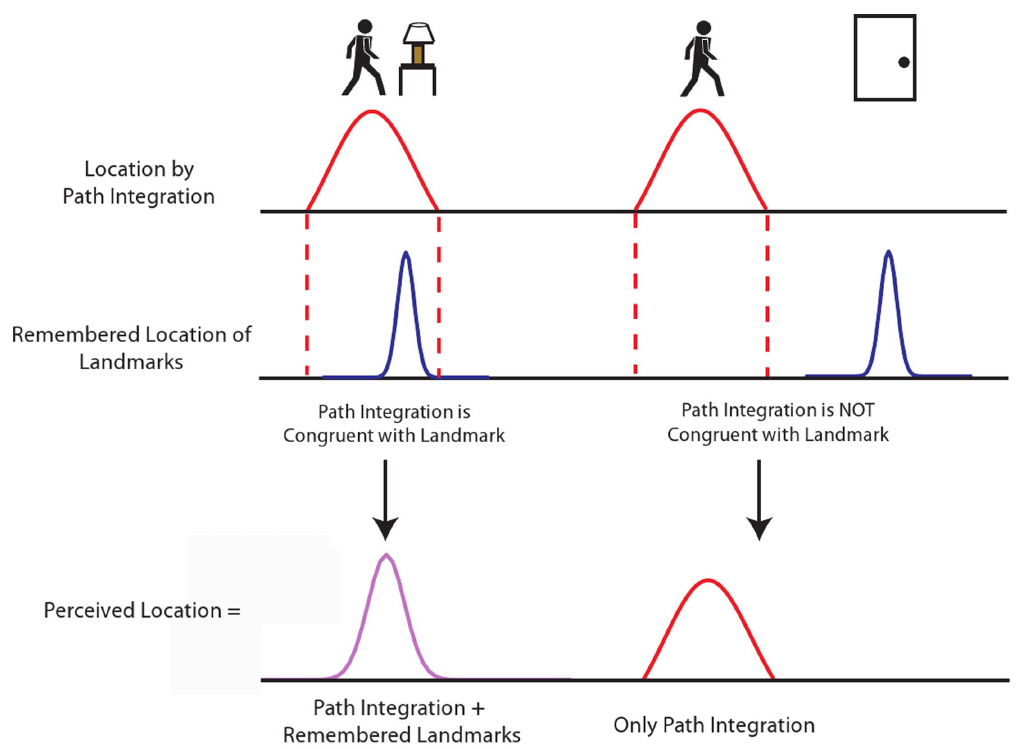
Figure 1. Predictions for integration of remembered landmarks and path integration. We predicted that when path integration and remembered landmarks provide congruent information about the observer’s location, then these sources of information are combined. In this case, the estimate of location is more precise and biased towards the more reliable source of information. If remembered landmarks are incongruent with path integration, then only path integration is used to estimate location.